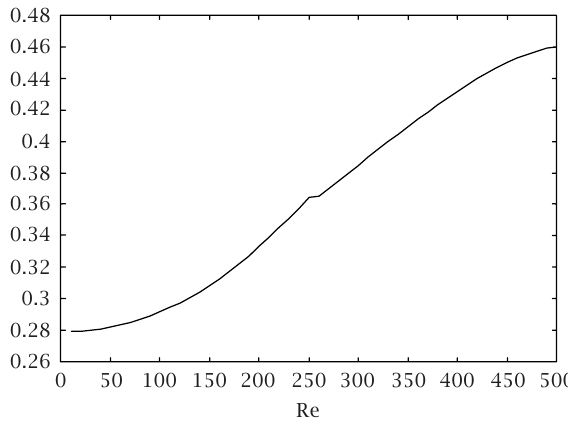
Figure 4.1. Torque distribution showing the onset of the first instability for Re ≈